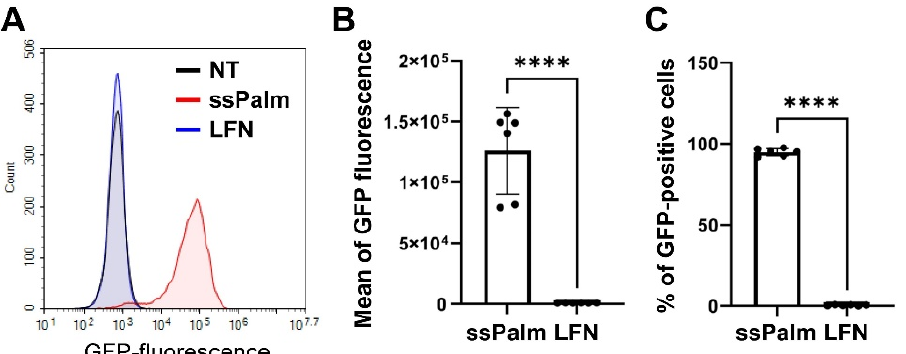
Figure 2. Flow cytometry analysis of GFP expression after mRNA transfection by the ssPalm-LNP